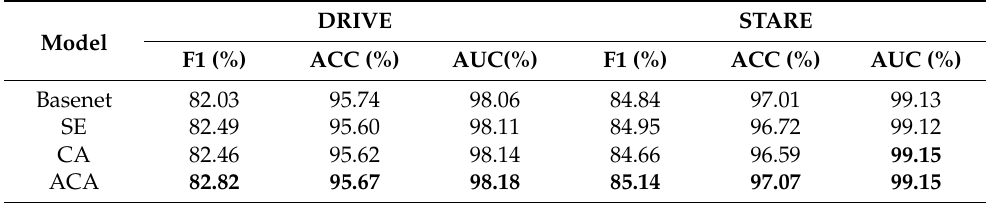
Table 4. Quantitative performance of different channel attention modules in retinal segmentation task.